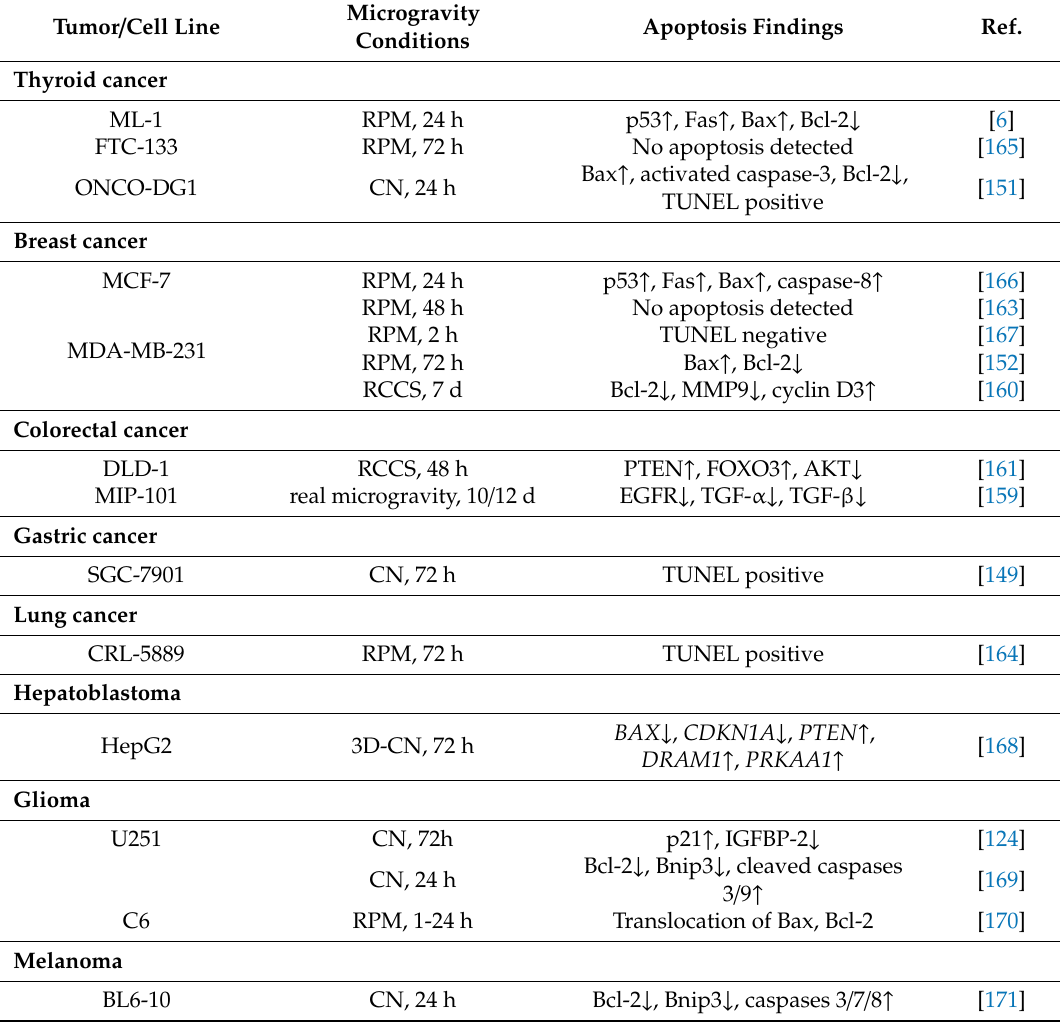
Table 1. Studies reporting on apoptosis in human cancer cell lines cultured in microgravity. Tumor / Cell